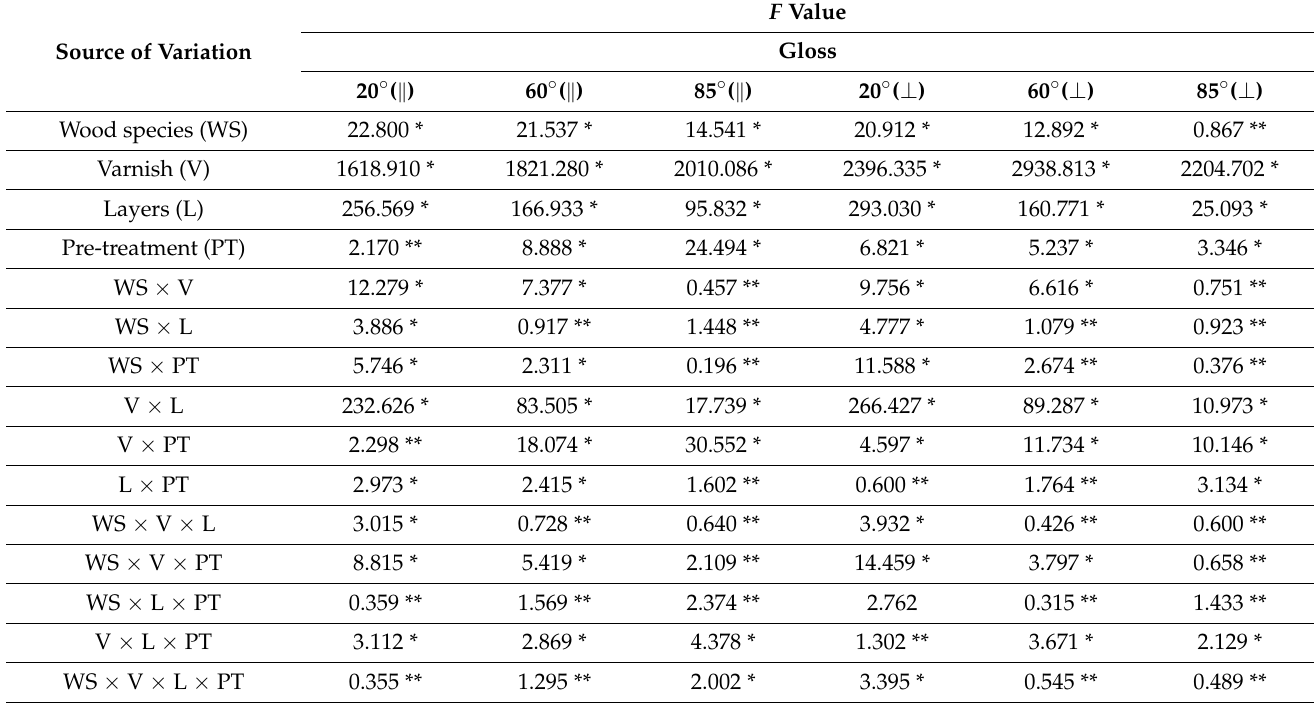
Table 1. ANOVA of surface gloss for varnished samples.